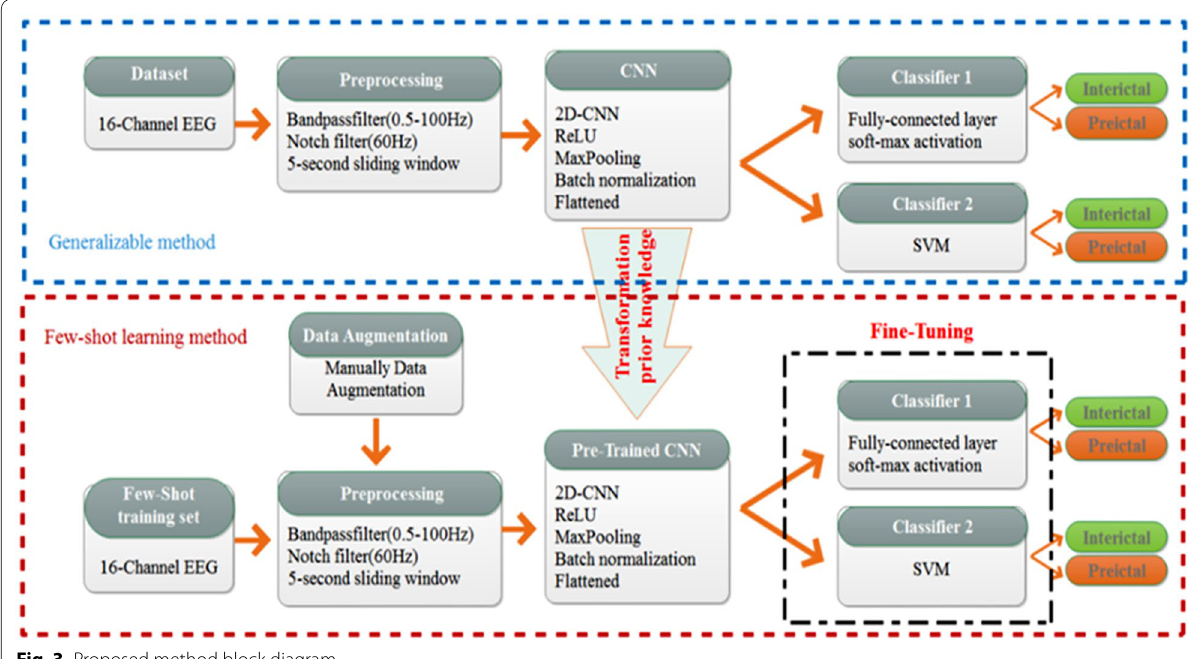
Fig. 3 Proposed method block